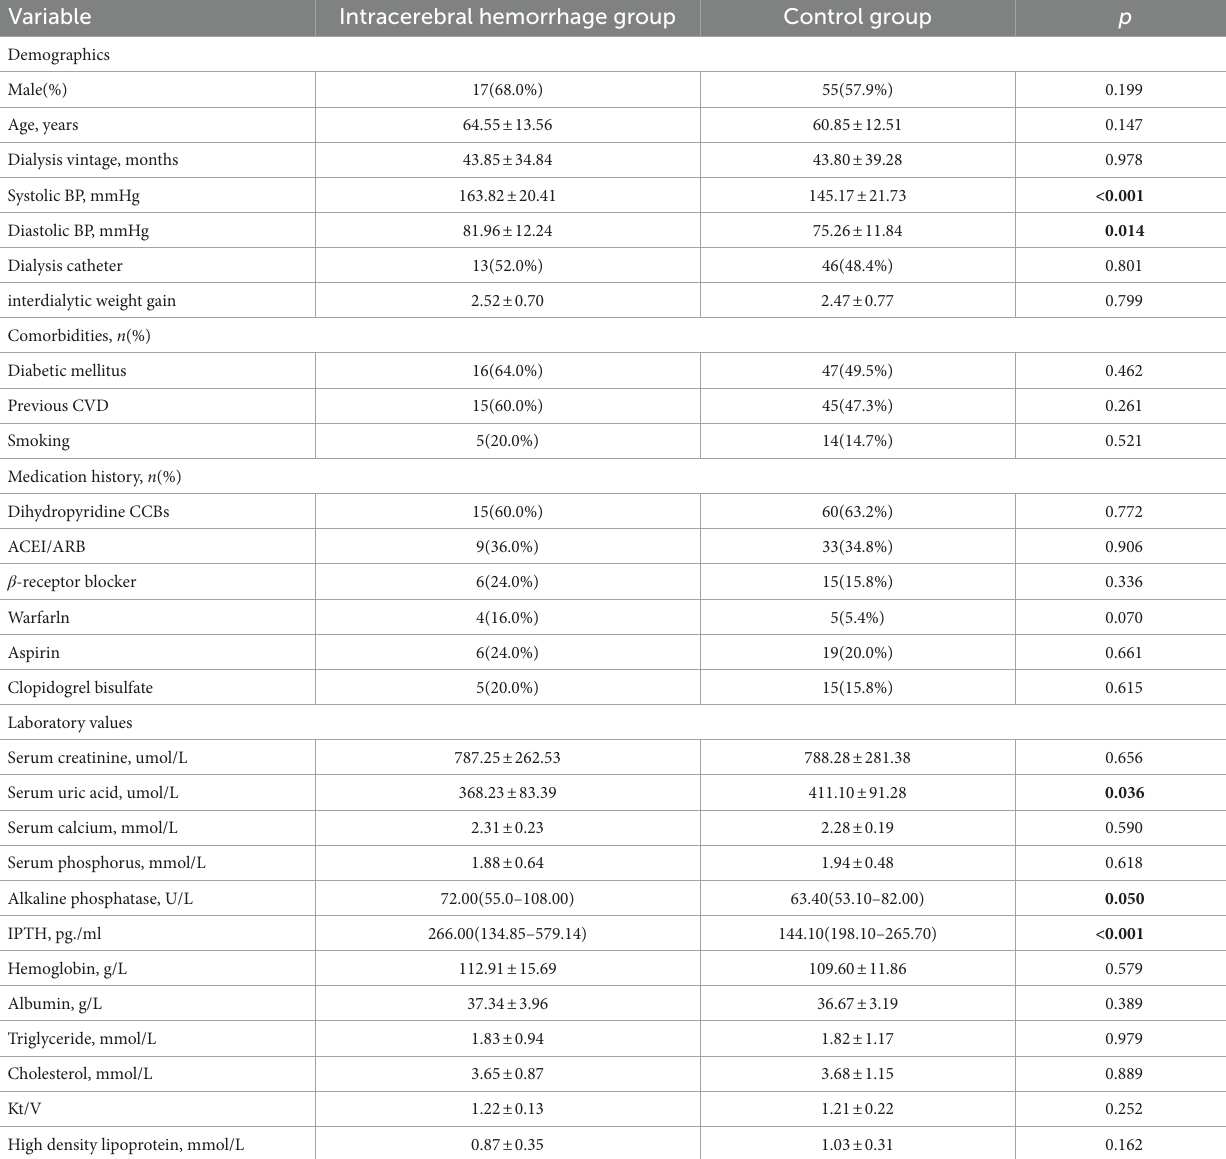
TABLE 1 Baseline characteristics of the study